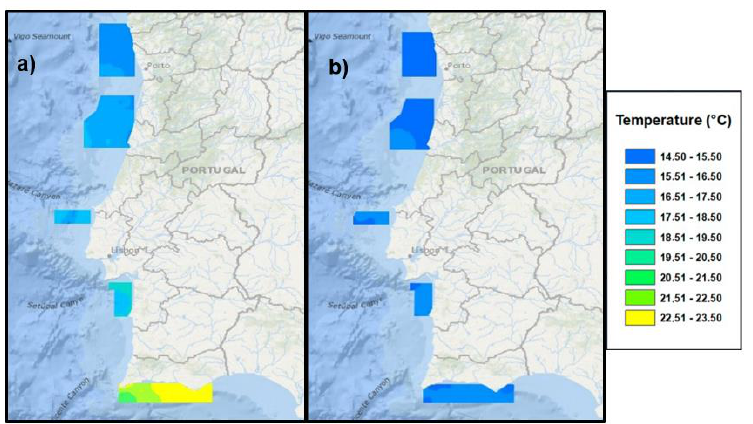
Figure 3. Map of surface temperature (°C) in the 5 study areas of the Portuguese coast in ( a ) October 2018 and ( b ) April 2019 surveys.